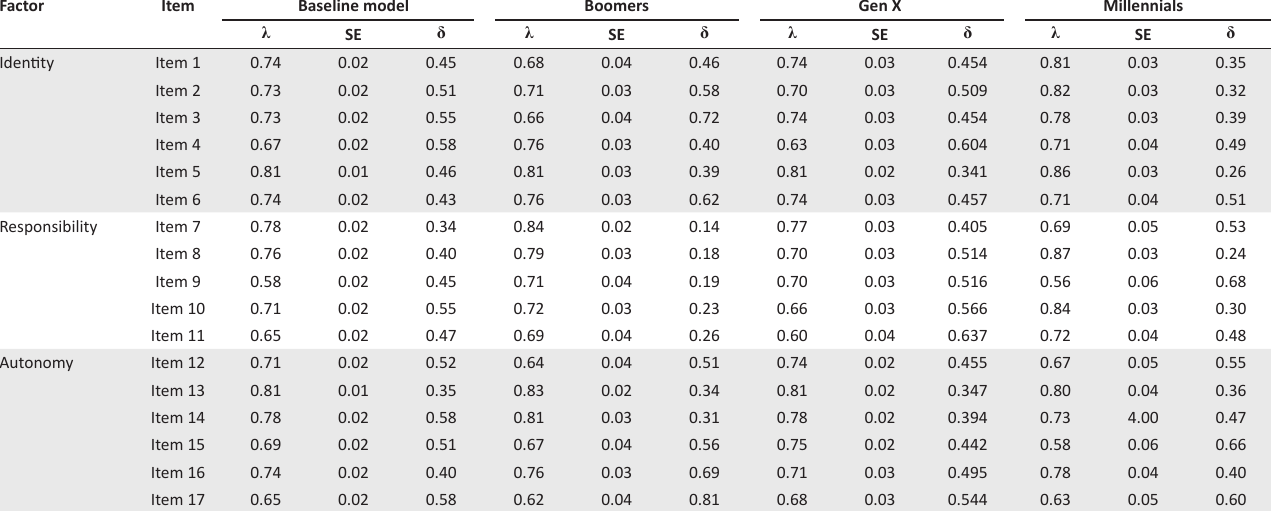
TABLE 4: Standardised factor loadings (λ) and uniqueness (δ) for the multigroup confirmatory factor analysis across all generational cohorts Factor Item